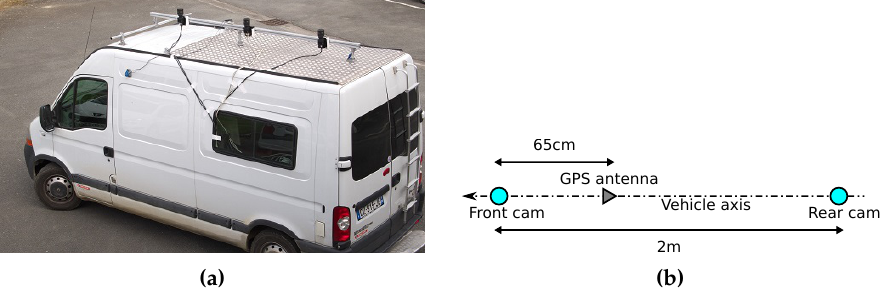
Figure 4. Truck with binocular stereovision configuration. The central camera of the picture is not used for this project. ( a ) IFSTTAR truck; ( b ) Sensors